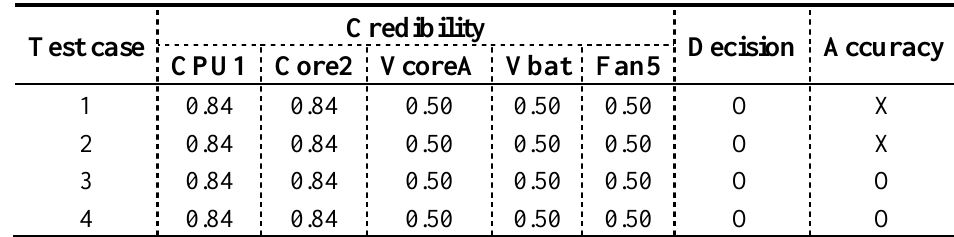
( F ) Results of a correlation-based network with a threshold of 0.90.